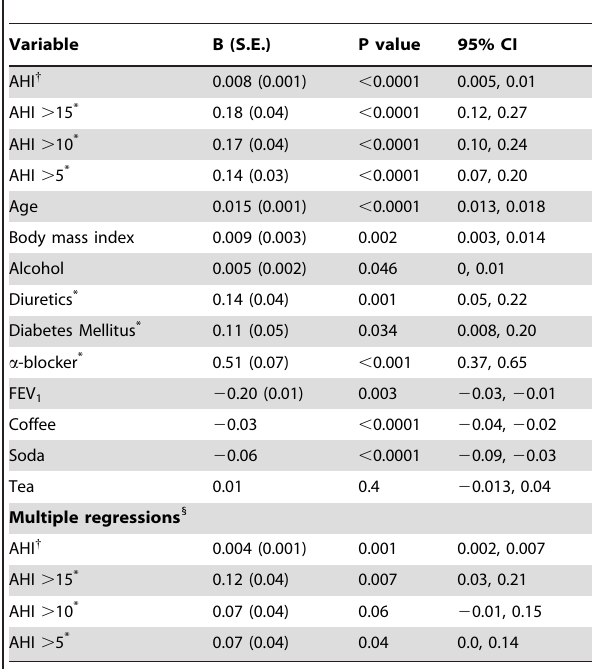
Figure 1. Proportions and numbers of patients with reported frequency of nocturia. Participants were queried as to how often in the prior year, did they awaken to go to the bathroom: never, rarely (1/ month or less), sometimes (2–4/month), often (5–15/month), and almost always (16–30/month).